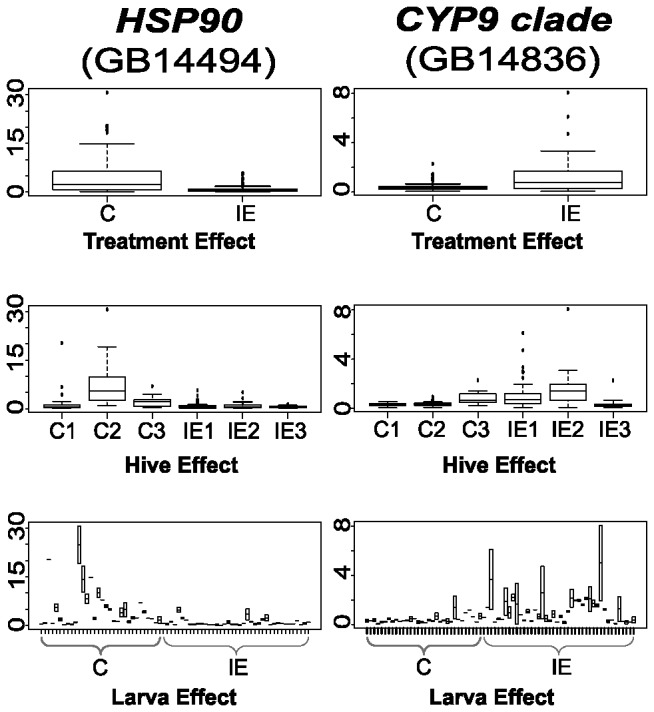
Multiplex RT-PCR validation of HSP90 and a P450 gene (CYP9-clade).Variance in measured RNA expression levels was assessed between treatment groups (left), among hives (middle) and between the two measurements taken for individual larvae (right/larval samples 1–34 came from control hives C1–C3; Larval samples 35–74 came from imidacloprid-exposed hives IE1–IE3. As two measurements were made for each larva, the height of each bar in the larva plot gives the range of values recorded; the mean value for each larva is indicated in the middle of this range. For those larvae that yielded only a single successful measurement for a given gene, only one point is shown. Box and whisker plots show 25th percentile (bottom of box), 50th percentile (middle of box), 75th percentile (top of box), median (line in middle of box), and full range of data (low bar to high bar). Relative expression levels are compared to a standardisation factor. The scale of the y-axis differs between plots for the two genes and indicates fold-difference for the expression level relative to the standardisation factor.